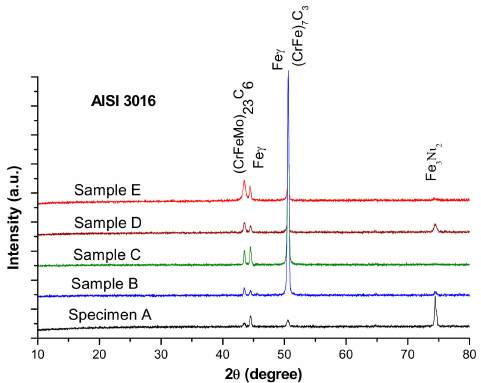
Figure 4. X-ray di ff raction patterns of AISI 316 modified stainless steel